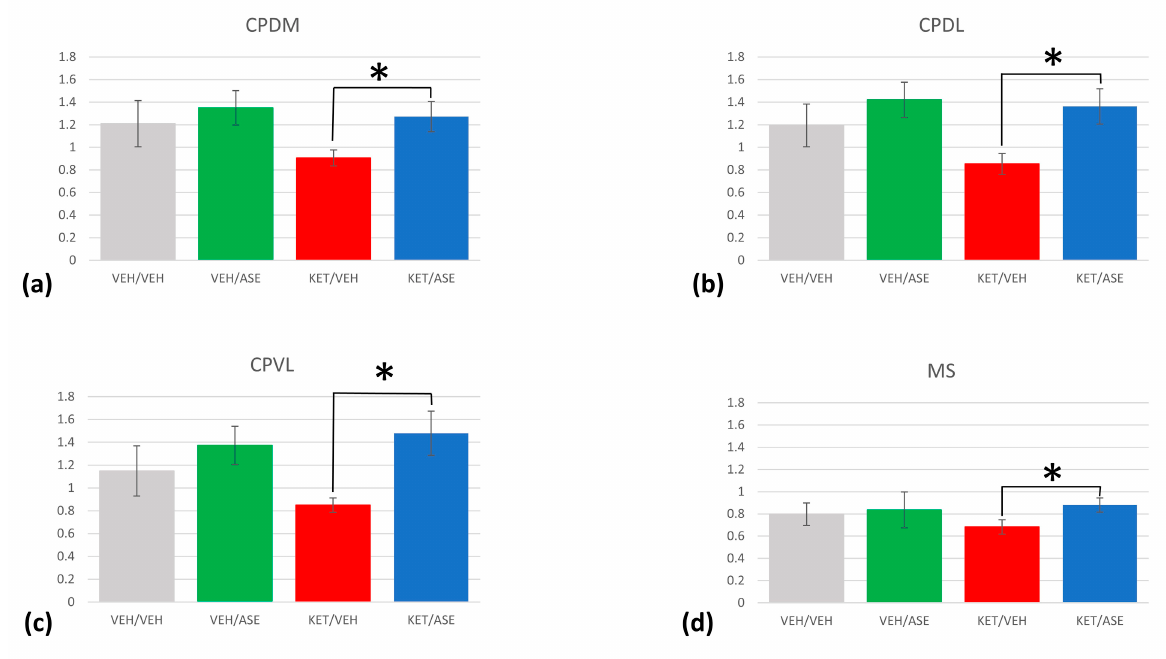
Figure 1. Homer1a mRNA levels in different treatment groups expressed as relative dpm ± sem. Significant differences between KET/VEH and KET/ASE groups were found in the dorsomedial ( a ), dorsolateral ( b ), ventrolateral ( c ) caudate-putamen, as well as in the medial septum ( d ). Asterisks denote statistically significant differences (Bonferroni adjusted p -value ≤ 0.001). CPDM =dorsomedial caudate-putamen; CPDL = dorsolateral caudate-putamen; CPVL = ventrolateral caudate-putamen; MS = medial septum.